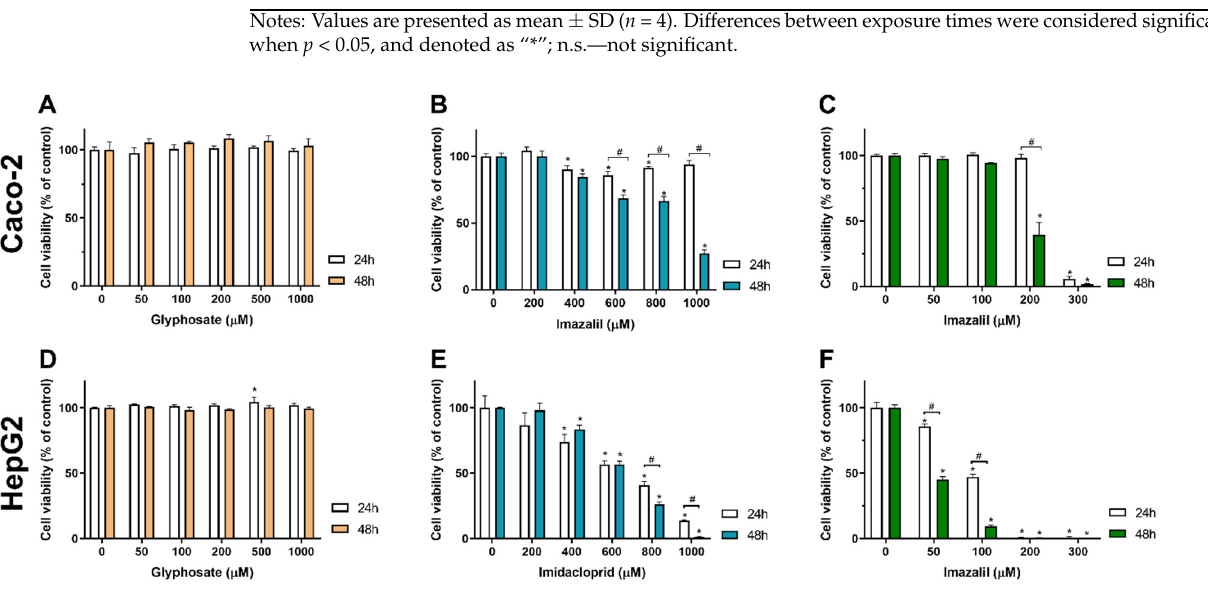
for Caco-2 and HepG2 cells subjected to the pesticides for 24 h and 48 h of exposure. The